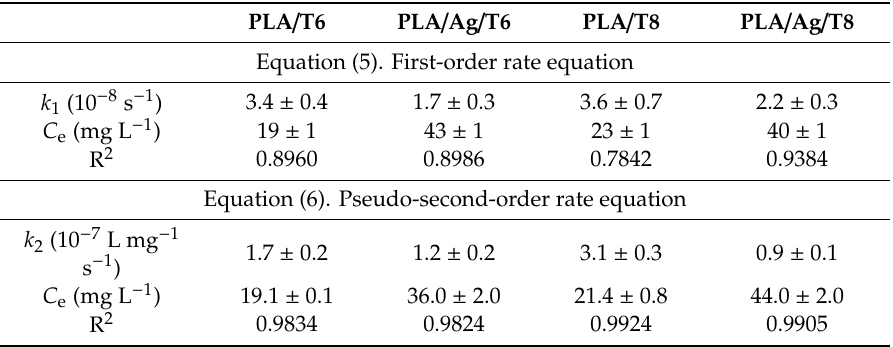
Table 4. Kinetic parameters for migration of thymol from PLA-based films using Equations (5) and (6). Mean ± SD (n =